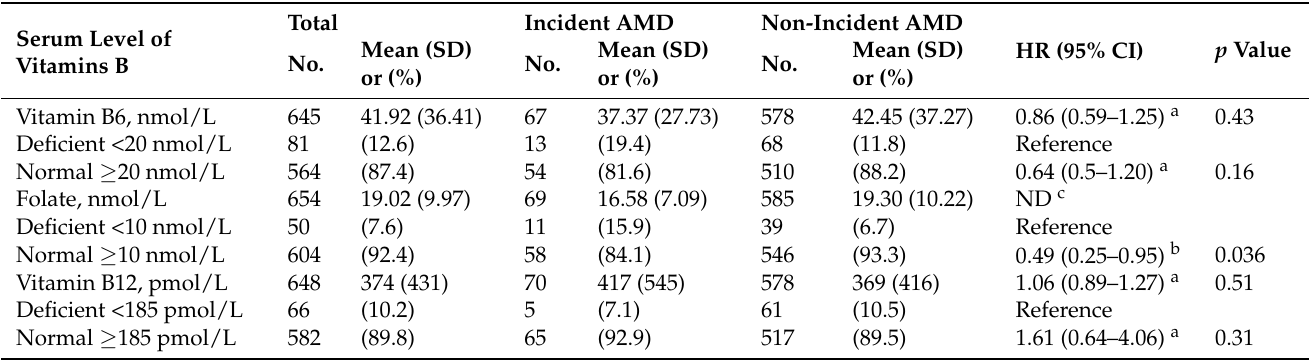
Table 3. Associations between serum vitamins B and incidence of advanced AMD in the Alienor Study 2001–2017.